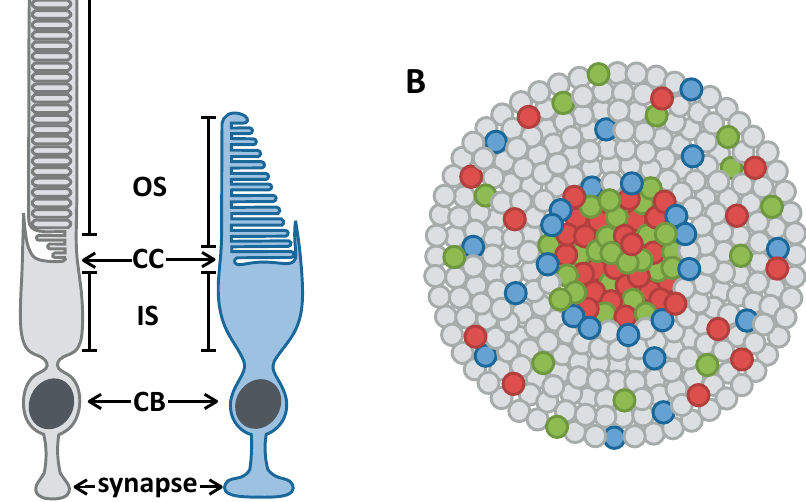
Figure 1. Anatomy of rod and cone photoreceptors and their organization in the human retina. ( A) Cartoons of a rod (grey) and cone (blue) photoreceptor. Photoreceptors have an outer segment (OS) that is packed with light-sensitive opsin proteins, a connecting cilium (CC) that connects the OS with the mitochondria-rich inner segment (IS), a cell body (CB), and a synapse. ( B ) Cartoon of the human photoreceptor mosaic. Humans have three types of cones: red, green, and blue, depicted in those respective colours. The peripheral retina is rod-dense with cones interspersed throughout, while the central retina is cone-dense.